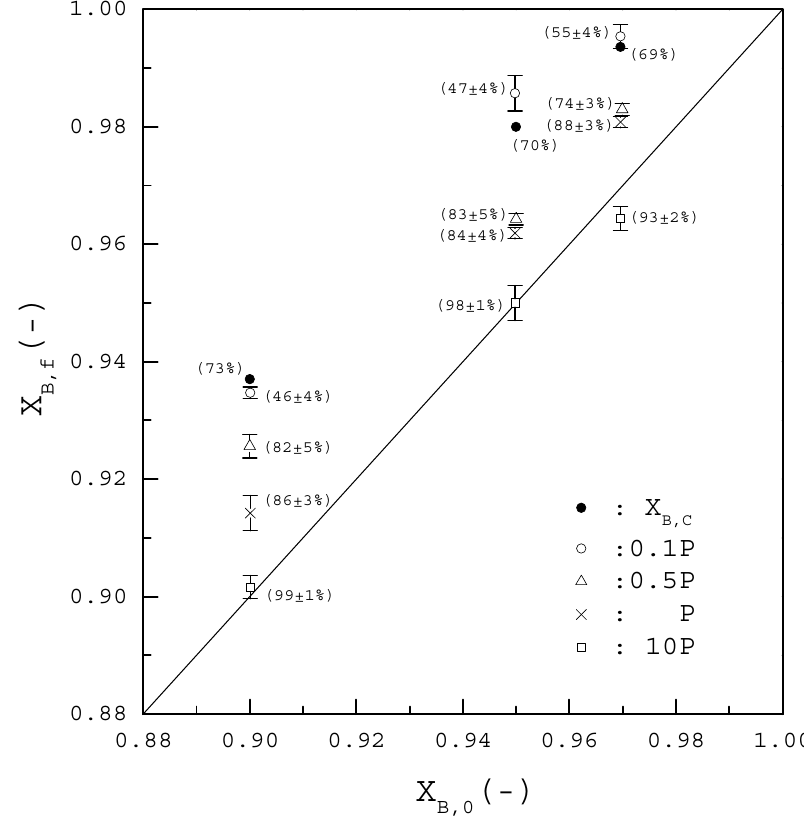
Figure 5. X B,f of the final product plotted against X B,0 of the initial feed for various 1 g feeds. The solid line represents X B,f = X B,0 indicating no further purification for the initial feed during SC. Solid circle represents the calculated X B,C and the number in parenthesis represents the calculated R C . Other symbols, including open circle, open triangle, cross sign, and open square, represent the average of the experimental X B,f for four repetitive experiments operated at the specified pressure and the error bar represents the 95% confidence interval for the experimental X B,f . The number in parenthesis represents the average of the experimental R f with the 95% confidence interval for the experimental R f . Note that no error bar is added for solid circle of the calculated X B,C . For example, cross sign represents the average X B,f when the operating pressures was controlled at P(T) during the cooling process. As a lower X B,f with a higher R f was observed for each feed compared to the calculated X B,C and R C , it was speculated that the calculated pressure P(T) in Figure 3 might be higher than the actual three-phase transformation pressure, leading to less impurity ( S -phenylglycinol) vaporized and more crystalline product formed from the melt during the cooling process. To consider the possible deviations between the calculated and the actual three-phase transformation pressure, various operating pressures are compared during the cooling process. The open circle in Figure 5 represents the average X B,f when the operating pressures were controlled at 0.1 × P(T) during the cooling process. Similarly, the open triangle represents the average X B,f when the operating pressures were controlled at 0.5 × P(T). The open square represents the average X B,f when the operating pressures were controlled at 10 × P(T).